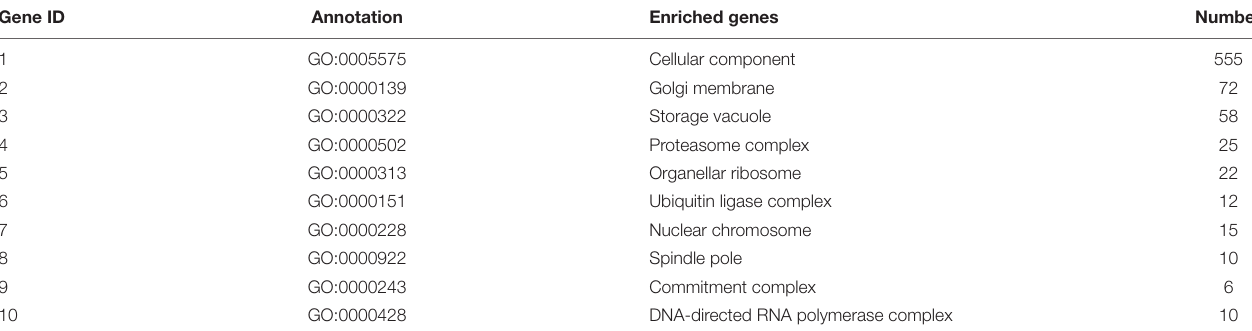
TABLE 7 | Top 10 important enriched GO terms of B. maydis for cellular functions differentially expressed in inoculated resistant and susceptible